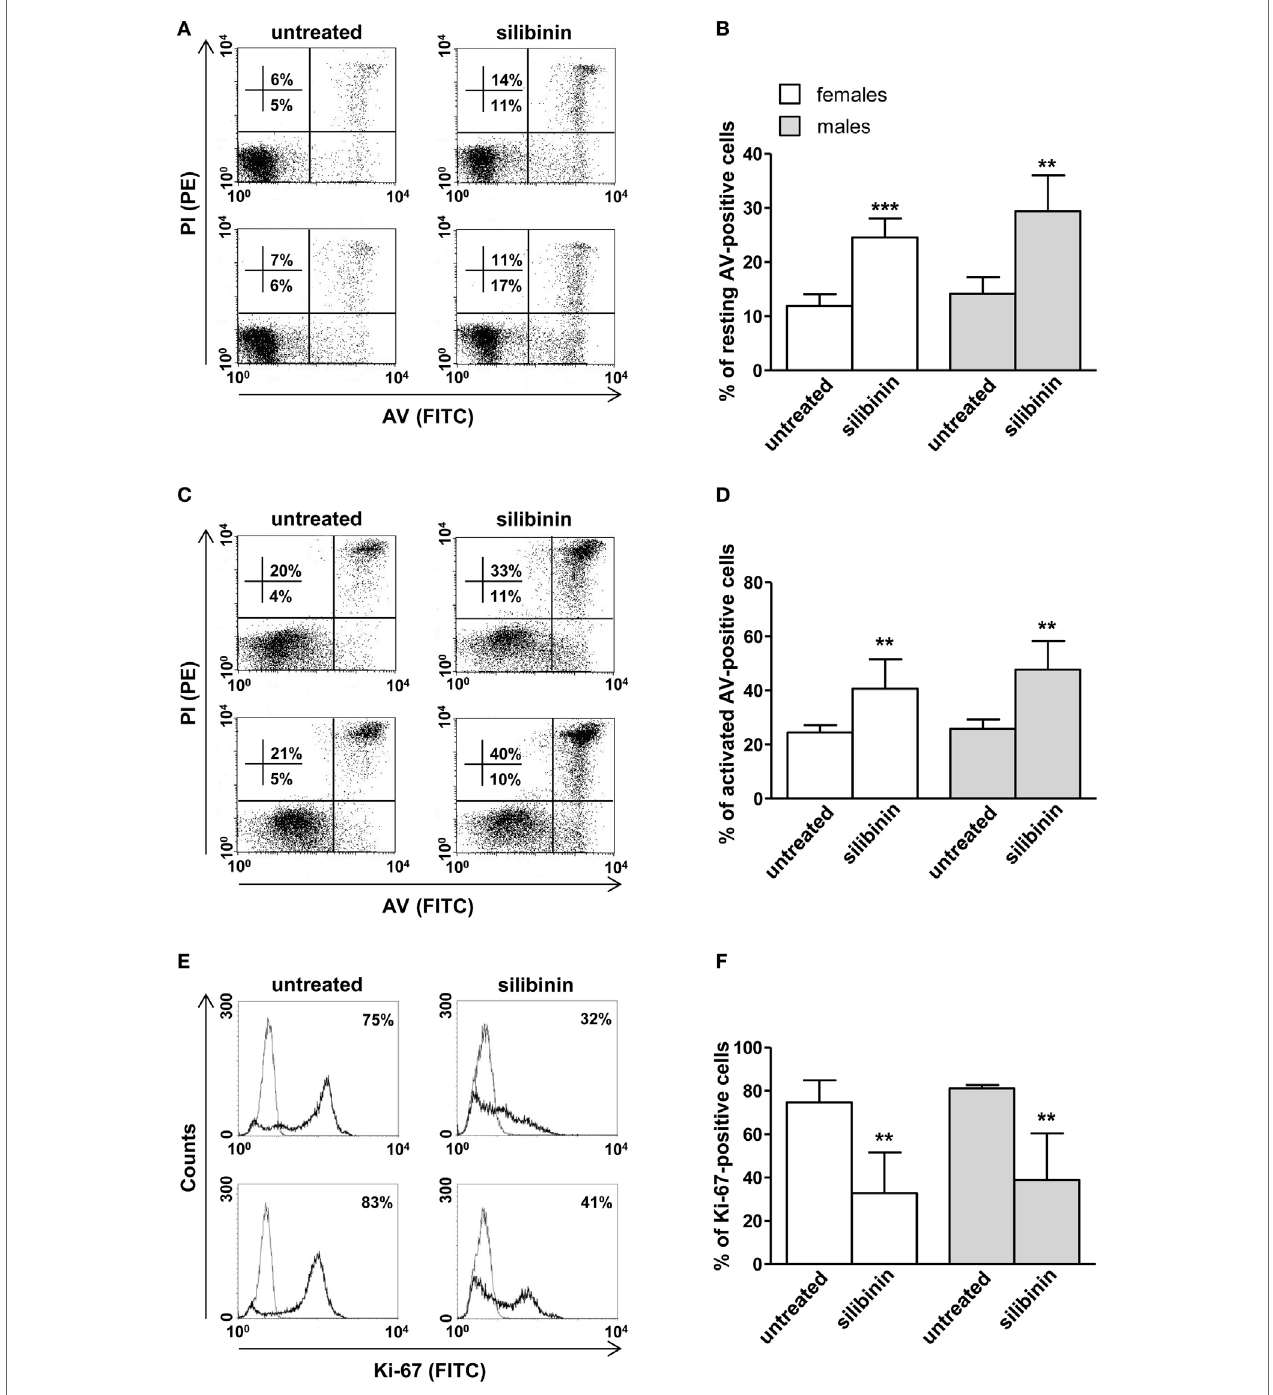
FigUre 2 | Silibinin-dependent effects on apoptosis and proliferation levels of peripheral blood T lymphocytes from female and male healthy subjects. All experiments were performed in 23 female and 21 male healthy subjects. (a–D) Apoptosis assay involving dual staining with annexin V (AV) and propidium iodide (PI) was carried out using flow cytometry in resting T cells treated or not with silibinin for 48 h (a,b) and in T cells activated by anti-CD3 monoclonal antibody (mAb) for 72 h and treated or not with silibinin for the last 48 h of culture (c,D) . Results from representative female (upper panels) and male (lower panels) healthy donors are shown (a,c) . Numbers reported represent the percentages of AV positive/PI negative (early apoptotic, bottom right quadrant) and AV positive/PI positive (late apoptotic or necrotic cells, top right quadrant). Data referred to both AV positive/PI negative and AV positive/PI positive cells are also reported as mean ± SD (b,D) . (e,F) Cell proliferation was evaluated by flow cytometry measuring Ki-67 nuclear antigen expression in T lymphocytes after activation with anti-CD3 mAb for 72 h and treatment with silibinin for the last 48 h of culture. Results from representative female (upper panels) and male (lower panels) healthy donors are shown (e) . Data are also reported as mean ± SD (F) . ** P < 0.01, *** P < 0.001 versus untreated